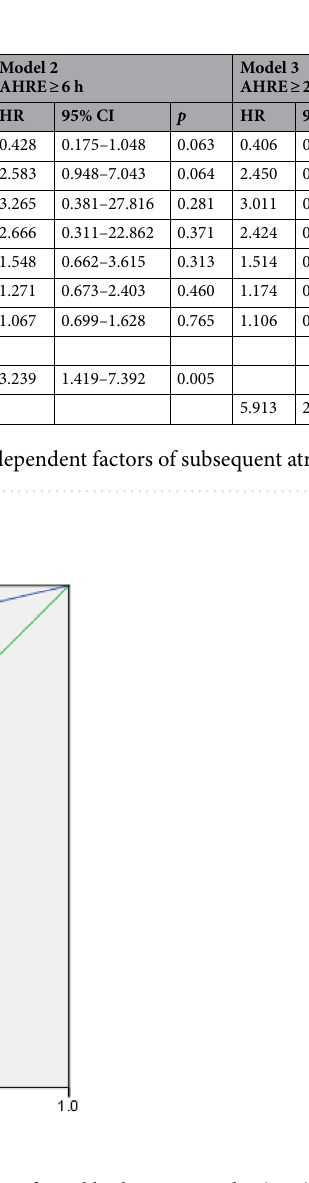
Figure 3. Receiver operating characteristic curve analysis of atrial high-rate episodes (min) for subsequent atrial fibrillation. Atrial high-rate episodes (min): cutoff value, 6 min; sensitivity, 70.6%; specificity, 77.0%; 6 h; sensitivity, 44.1%; specificity, 89.0%; 24 h; sensitivity, 41.2%; specificity, 94.0%; area under the curve 0.806; 95% confidence intervals 0.722–0.889; p < 0.001.